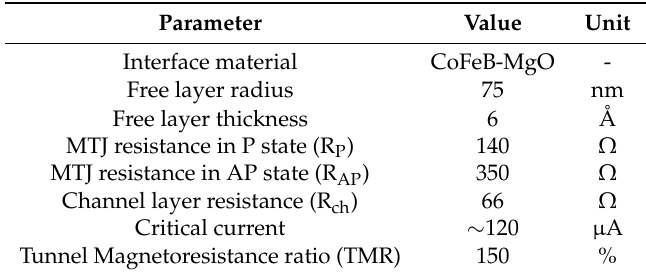
Table 1. Key parameters of an SOT-MTJ